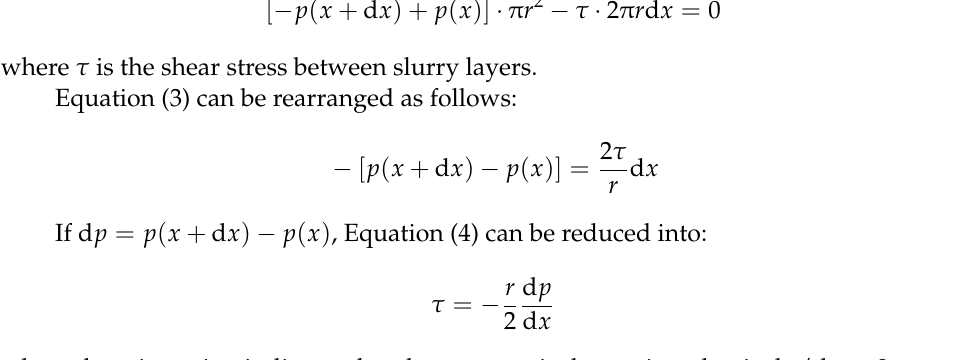
Figure 3. Stress analysis diagram of Bingham slurry in a tube. ( a ) The stress of the tube fluid; ( b ) fluid